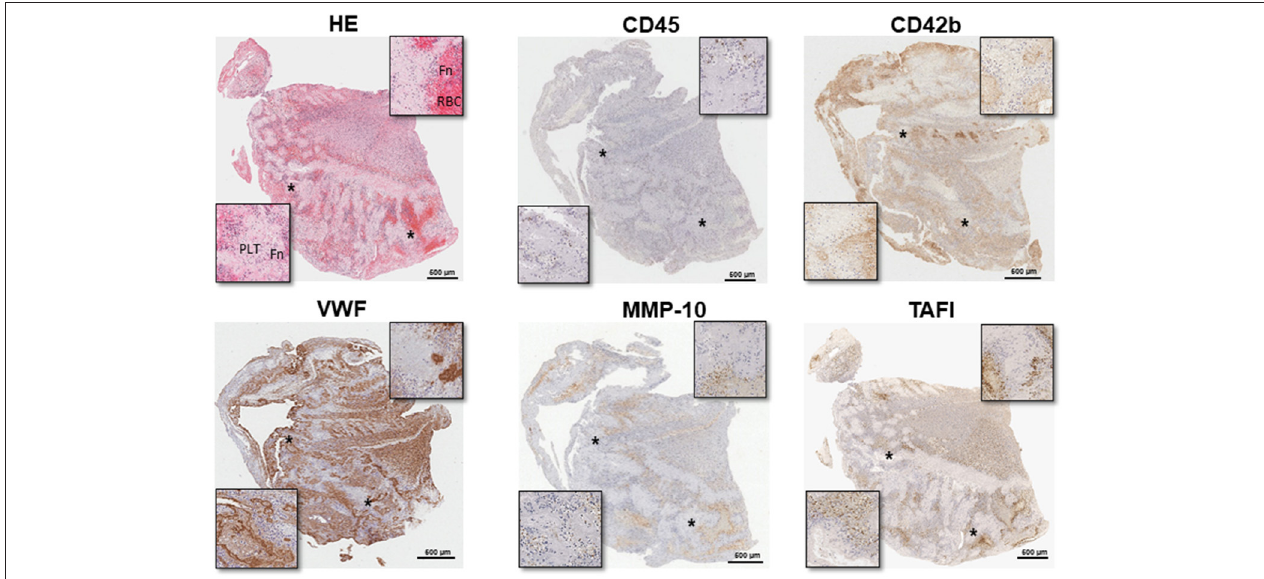
FIGURE 2 | Location and distribution of different cellular and hemostatic parameters in retrieved stroke thrombi. Representative immunohistological images of consecutive thrombi sections stained with hematoxylin & eosin (H&E), allowing the identification of fibrin/platelet aggregates (pink), red blood cell (RCB) (red), and nucleated cells (dark blue); leukocytes (CD45), von Willebrand Factor (VWF), platelets (CD42b), matrix metalloproteinase-10 (MMP-10), and thrombin-activatable fibrinolysis inhibitor (TAFI), stained in brown. Magnification images of selected areas (*). Scale = 300 µ m. Fn, fibrin; PLT, platelets; RBC, red blood cells.